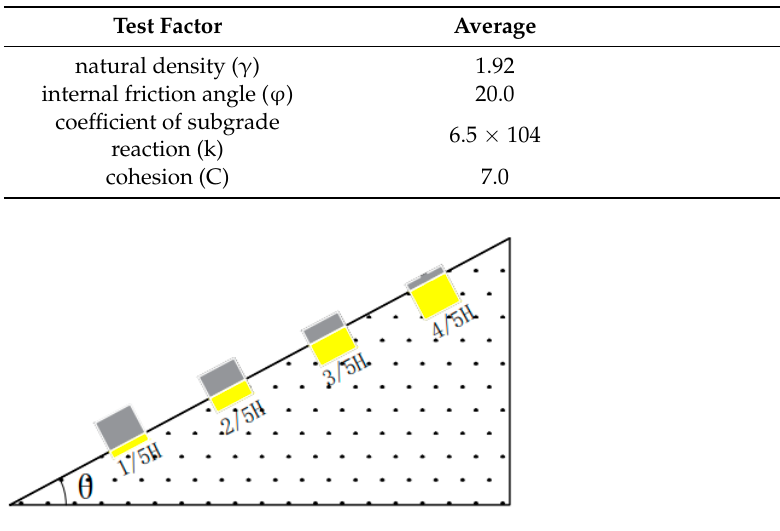
Figure 6. Test scheme.